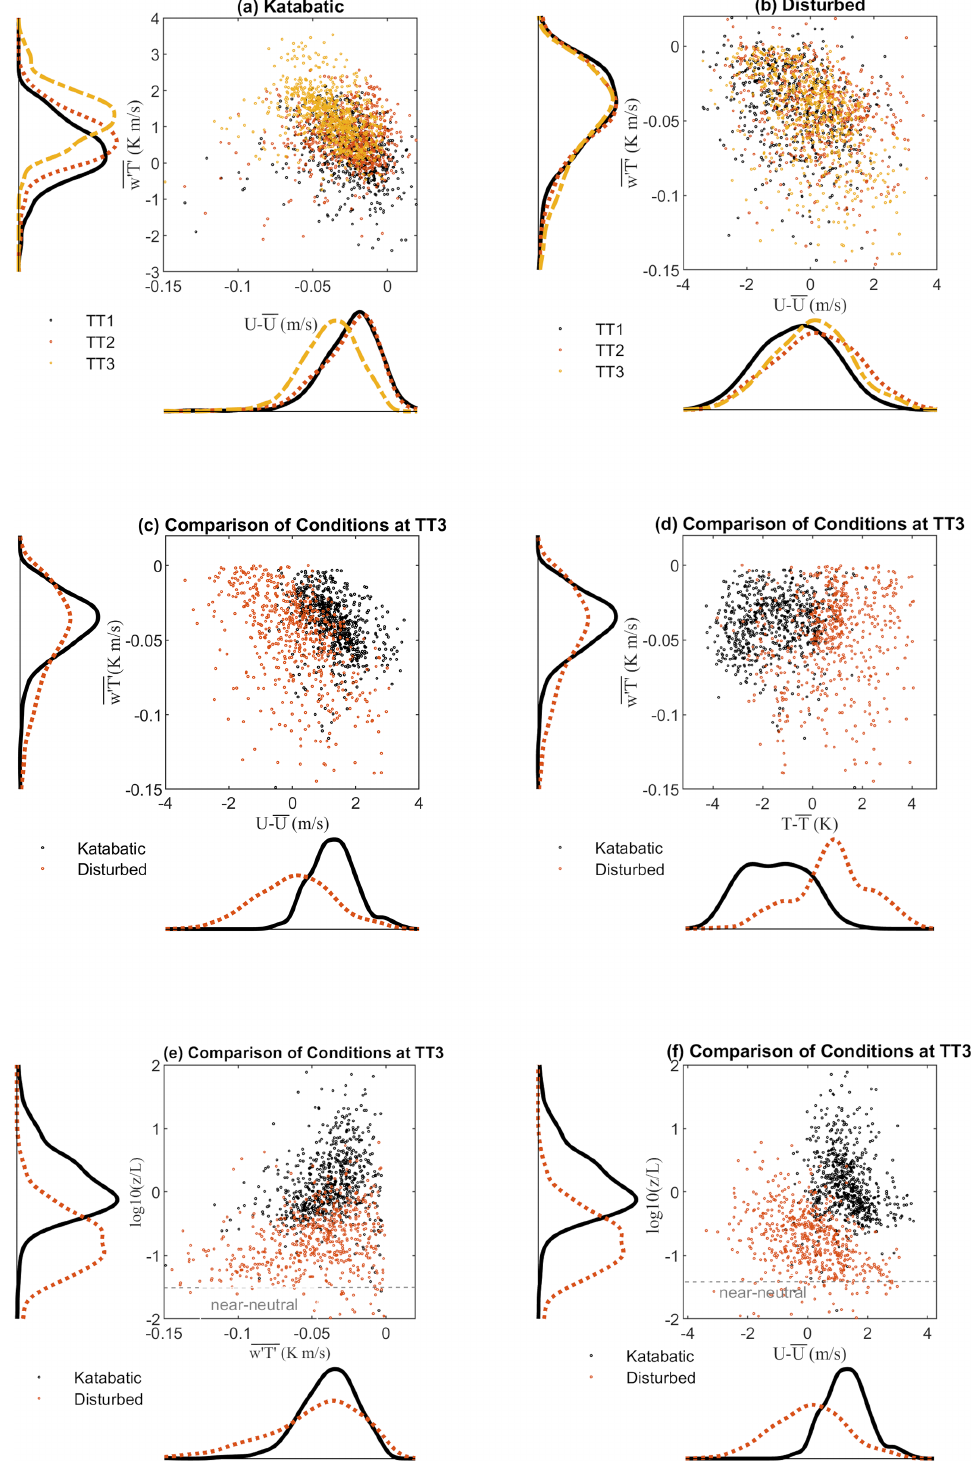
Figure 8. Vertical heat flux plotted against anomalies of wind speed from mean daytime wind speed shown for stations TT1–TT3 for katabatic conditions (a) and disturbed conditions (b) . Vertical turbulent heat flux plotted against anomalies of wind speed from mean daytime wind speed (c) and against anomalies of air temperature from mean daytime air temperature (d) shown for station TT3 for katabatic and disturbed conditions. Vertical turbulent heat flux (e) and normalized wind speed (f) plotted against the logarithm-of-stability parameter z/L at TT3 during katabatic and disturbed